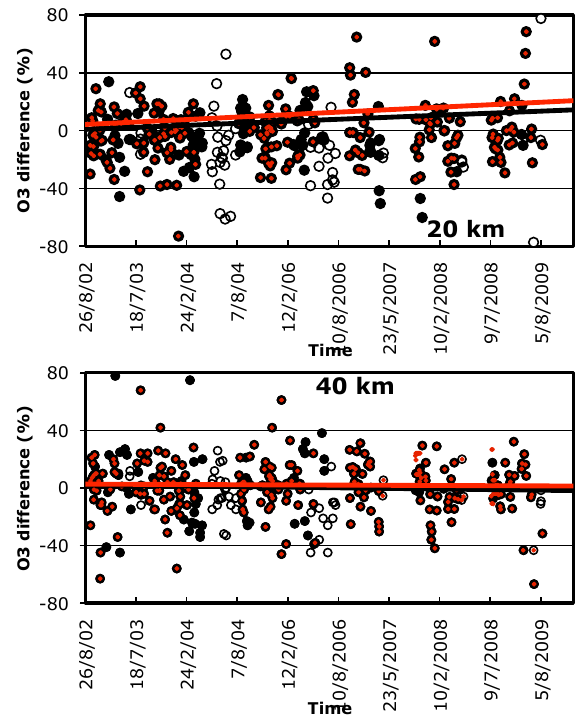
Fig. 8. Data comparison between GOMOS and the OHP DIAL lidar at 20km (a) and 40km (b). Open circles correspond to the bright and twilight illumination conditions while black dots correspond to dark conditions. The best stars (Fig. 6) are also highlighted with red dots in the centre. Lines correspond to root mean squared linear regressions for only dark sky observation conditions (black) and in addition for the selected stars